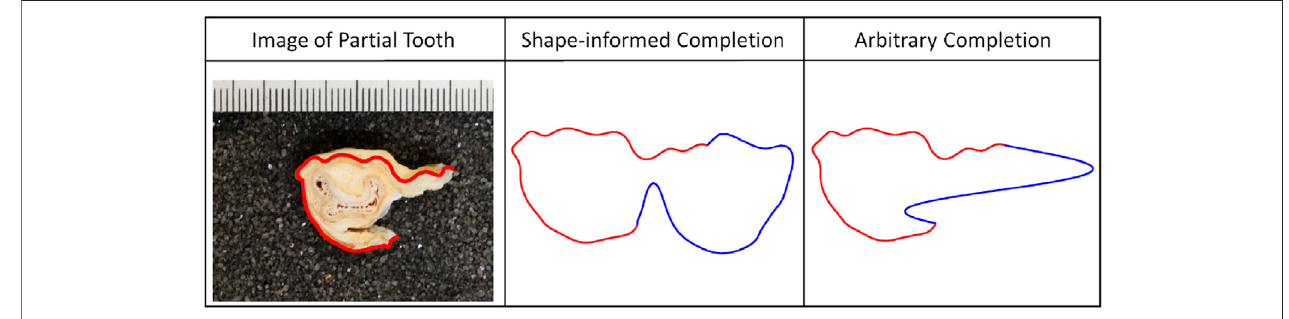
FIGURE 1 | Anthropological application with bovid teeth . Left: Image of a partial tooth with the segmentation overlaid in red. Middle; Right: Shape-informed and arbitrary completions (blue) of the observed partial tooth (red),